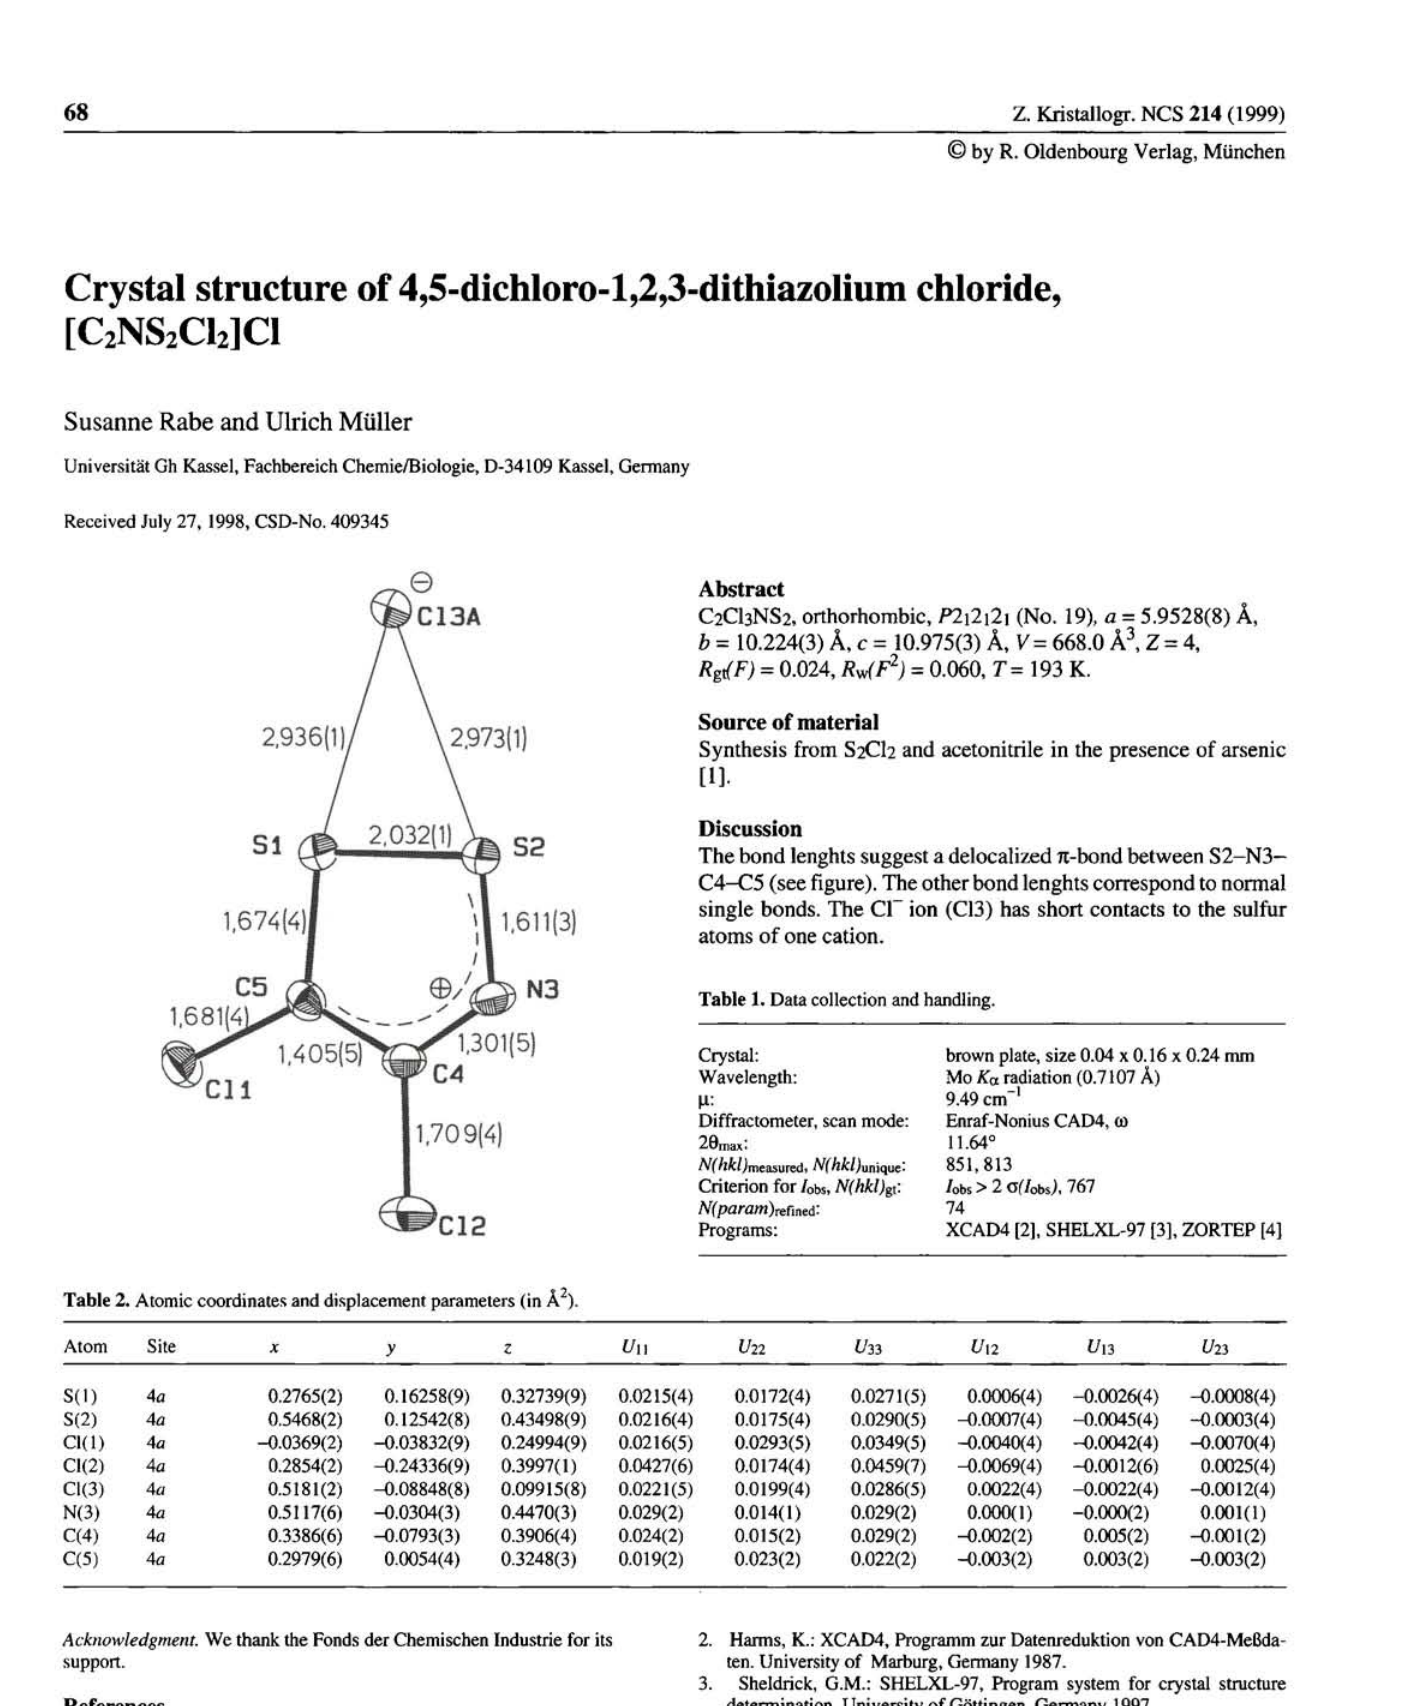
Table 2. Atomic coordinates and displacement parameters (in Â 2